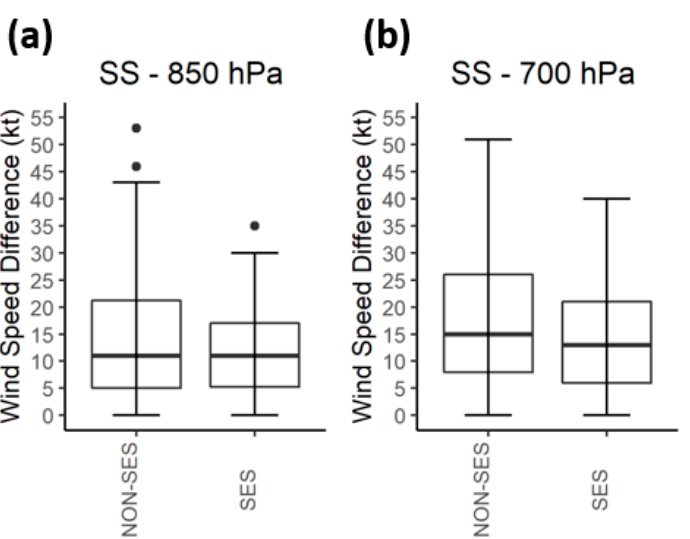
Figure 6. The variation in the wind speed difference between the upper atmospheric levels (850 and 700 hPa levels) and point “B” (specified on the western Black Sea surface) in SES and non-SES events. ( a ) the wind speed difference between the 850 hPa level and point “B”, ( b ) the wind speed difference between the 700 hPa level and point “B”.